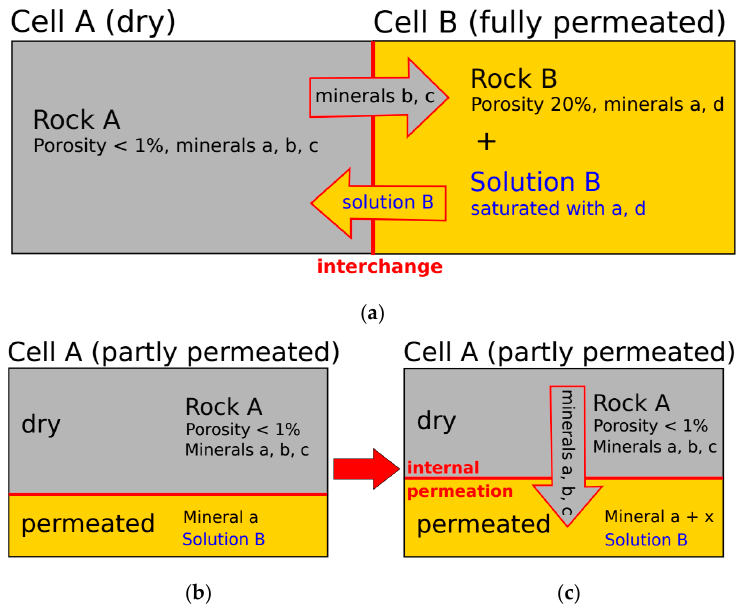
Figure 5. ( a ) Interchange at the dissolution front leads to ( b ) partly permeated cells; ( c ) internal dissolution of dry minerals causes further permeation of the cell as well as mineral precipitation.